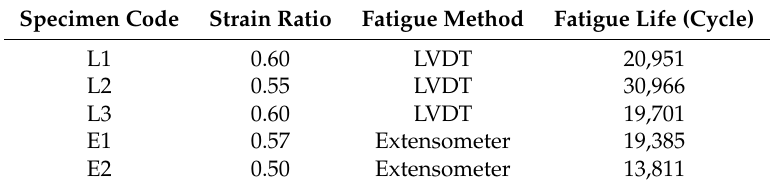
Figure 2. ( a ) Fatigue testing system with the data acquisition set-up; ( b ) the specimen E2with double axial extensometers; ( c ) failed specimens where failure locations are marked with the red circles and sensor locations are indicated by black vertical ticks. Table 1. Test parameters for fatigue experiments. LVDT, linear variable differential